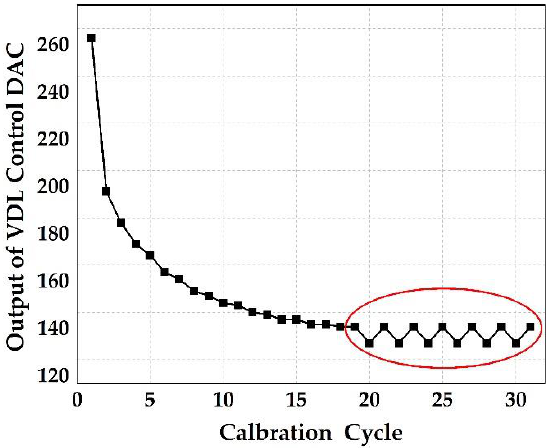
Figure 5. Simulated the calibration convergence with non-ideal 9 bit DAC.